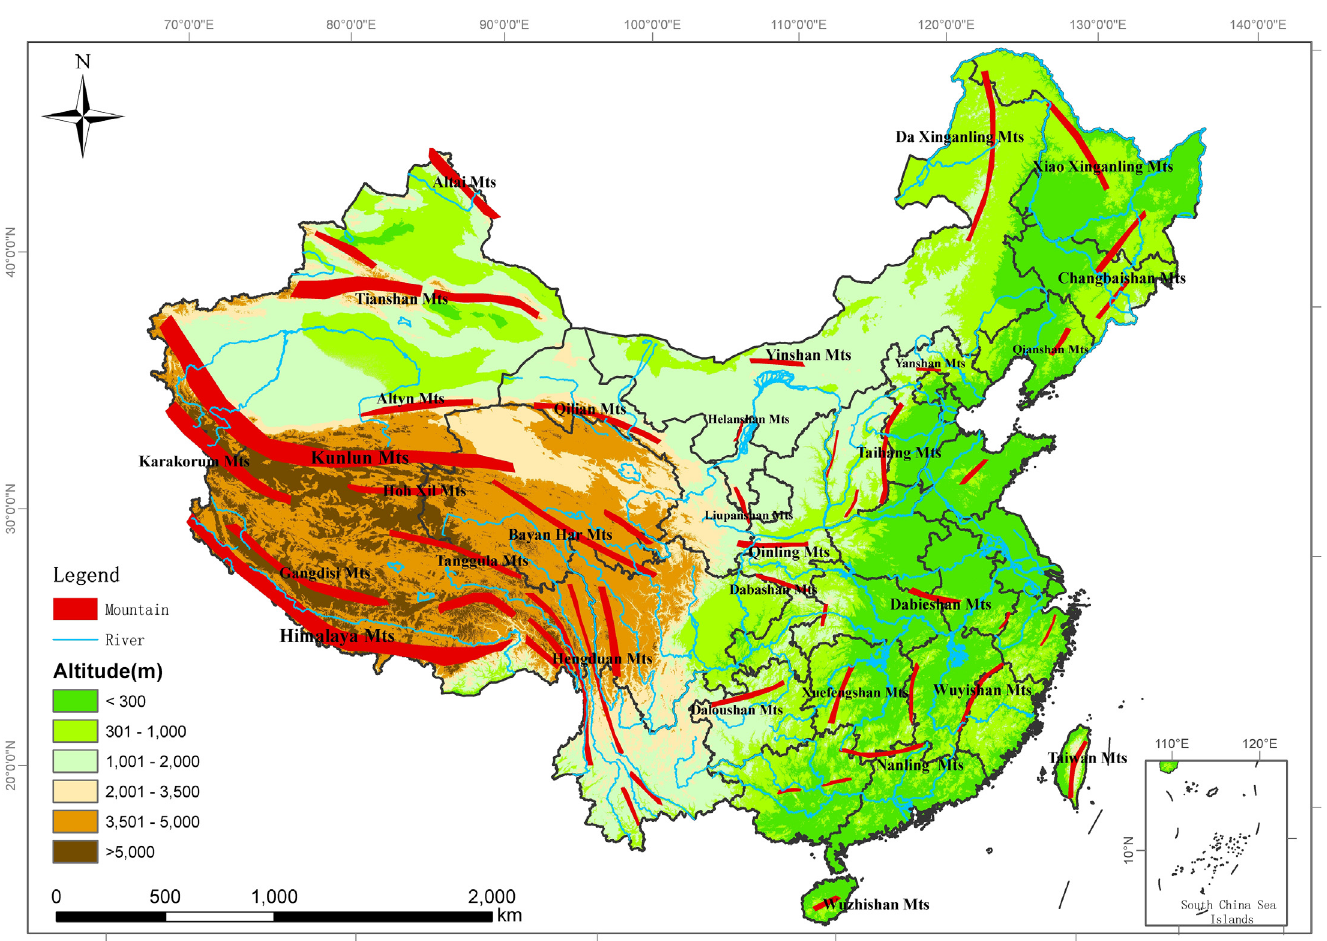
Fig 1. Sketch map of China showing elevation and major mountain ranges. The names of major mountain ranges were derived from Shen (2001). The inset in the right bottom of the figure shows the south boundary of China, including all islands in the South China Sea. This figure was used only for illustrative